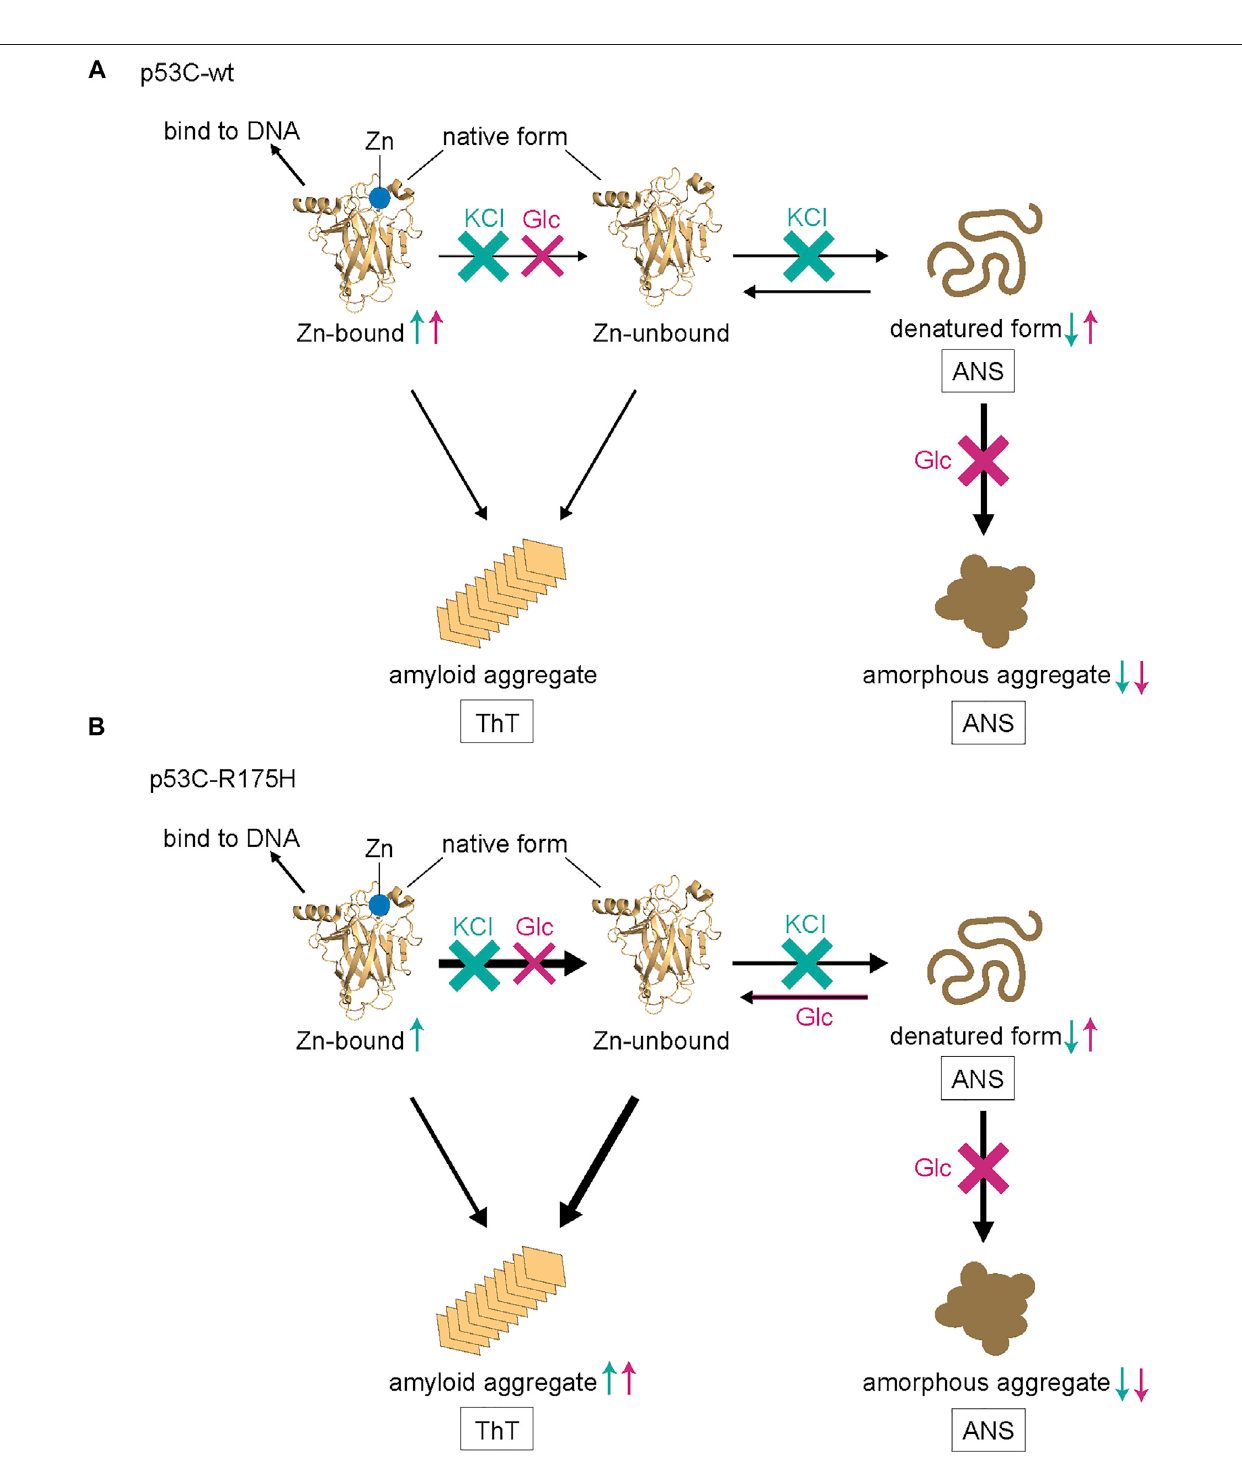
FIGURE 6 | A model of the denaturation and aggregation process of p53C-wt (A) and p53C R175H (B) . ANS predominantly stains the denatured form and amorphous aggregate, while ThT stains amyloid aggregate. Those that increase or decrease with KCl are represented by cyan arrows, while those that increase or decrease with Glc are represented by magenta arrows, either up or